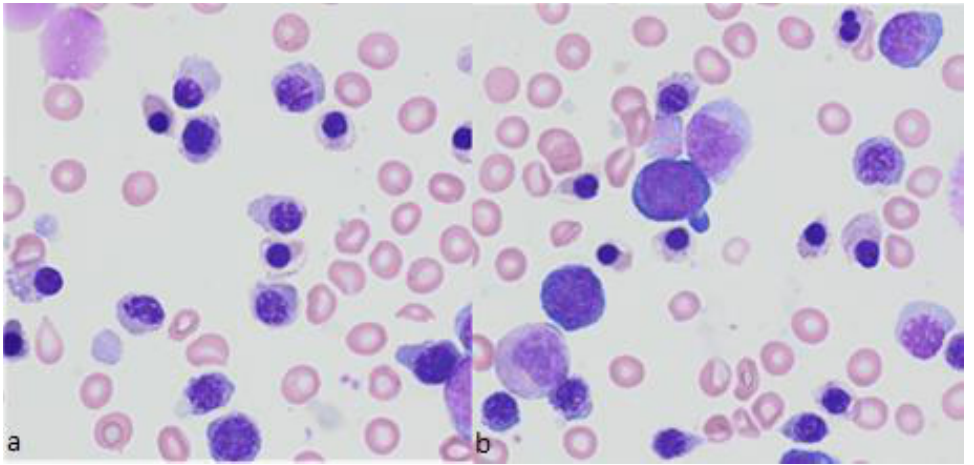
Figure 2. Representative bone marrow smears from a patient with beta-thalassemia major. ( a , b ) Bone marrow smears showing erythroid hyperplasia: erythroblasts are dystrophic with abnormal condensation of nuclear chromatin, vacuolation, and Pappenheimer bodies. May-Grünwald- Giemsa, magnification ×500.